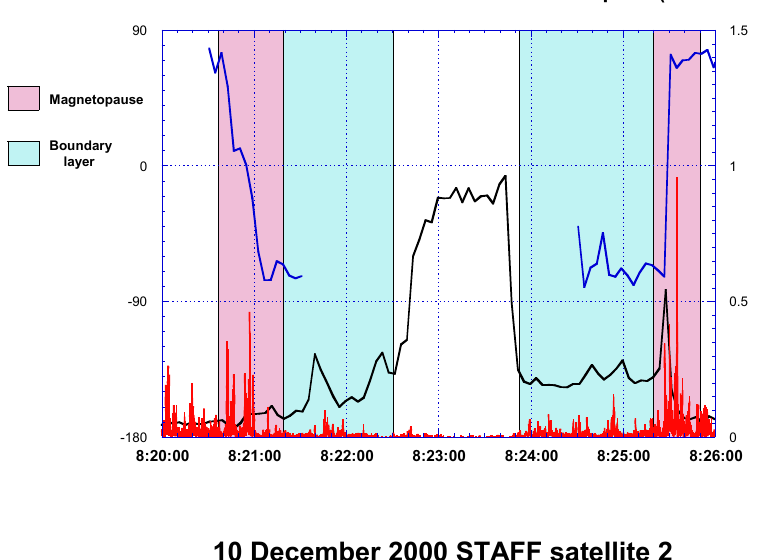
10 December 2000 STAFF satellite 2